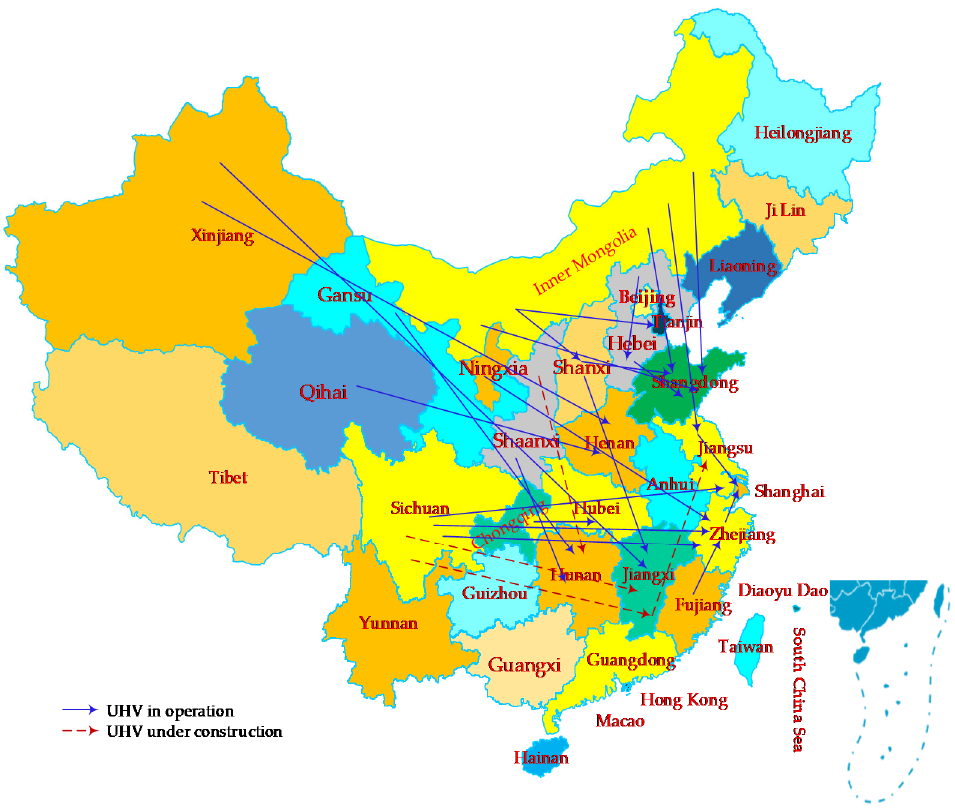
Figure 11. UHV lines in operation and under construction. Source: state grid. http://www.sgcc.com. cn/html/sgcc_main_en/col2017112610/column_2017112610_1.shtml (accessed on 24 April